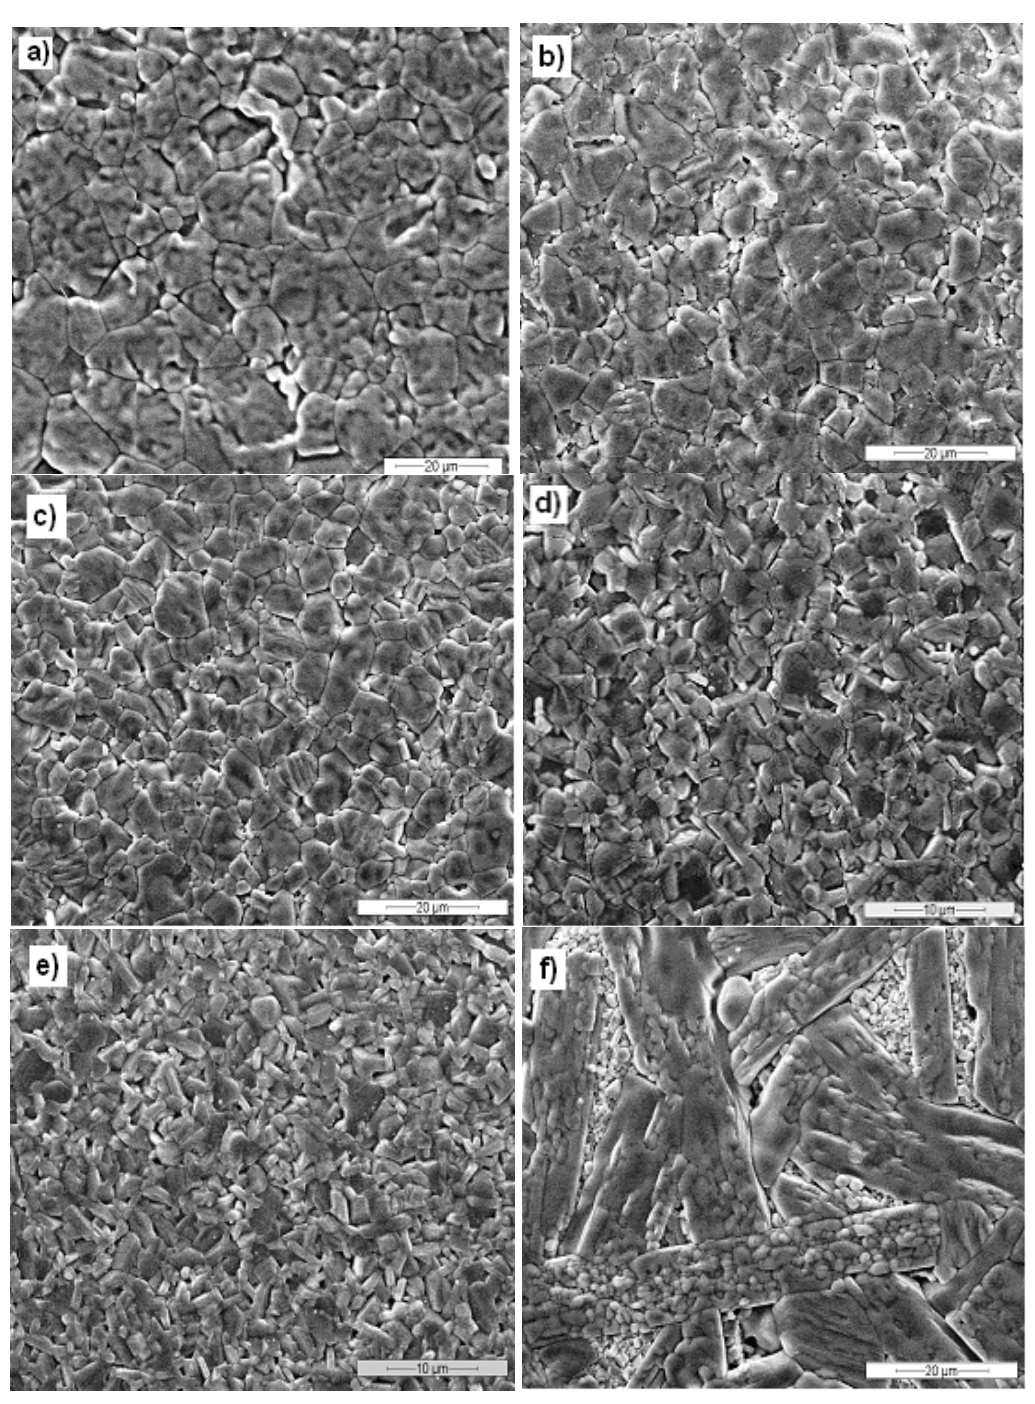
Figure 3. SEM micrographs of sintered samples: ( a ) H (1000×); ( b ) 3% BA (1000×); ( c ) 4% BA (1000×); ( d ) 5% BA (2000×); ( e ) 10% BA (2000×); ( f ) 14% BA